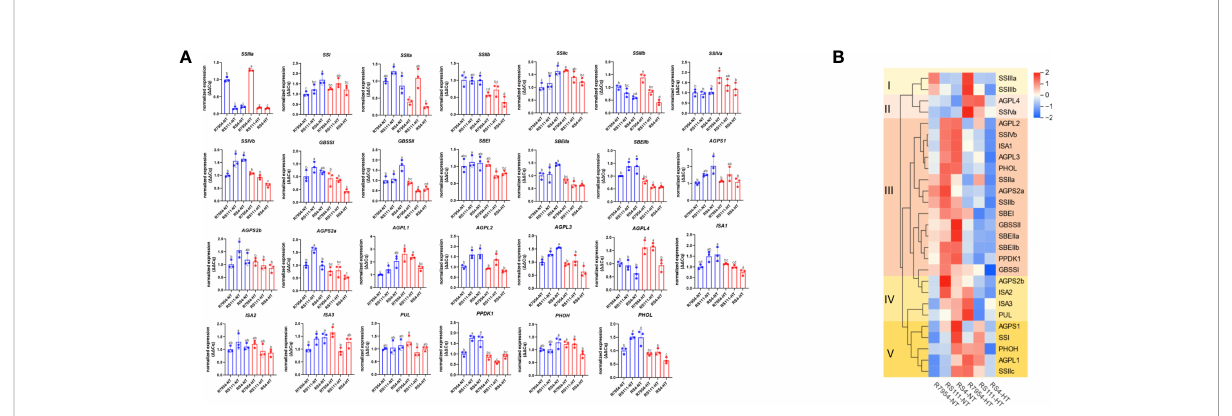
FIGURE 2 Expression levels of different genes in the three varieties under normal temperature (NT) and high temperature (HT) (A) and the clustering according to their expression levels (B) . The same small letter indicated that there were no signi fi cant differences among different samples at the P < 0.05